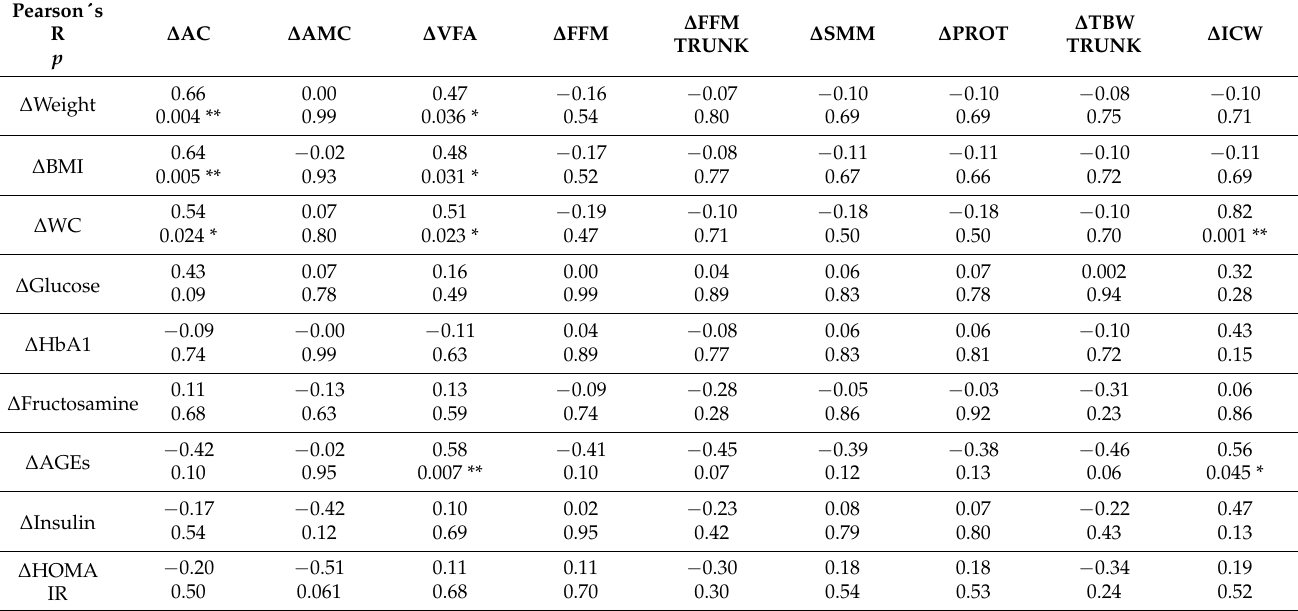
Table 6. Correlation analysis among studied parameters in obese hyperglycemic women ( n = 20) before and after the weight reduction program. The correlation is significant: * p ≤ 0.05; ** p ≤